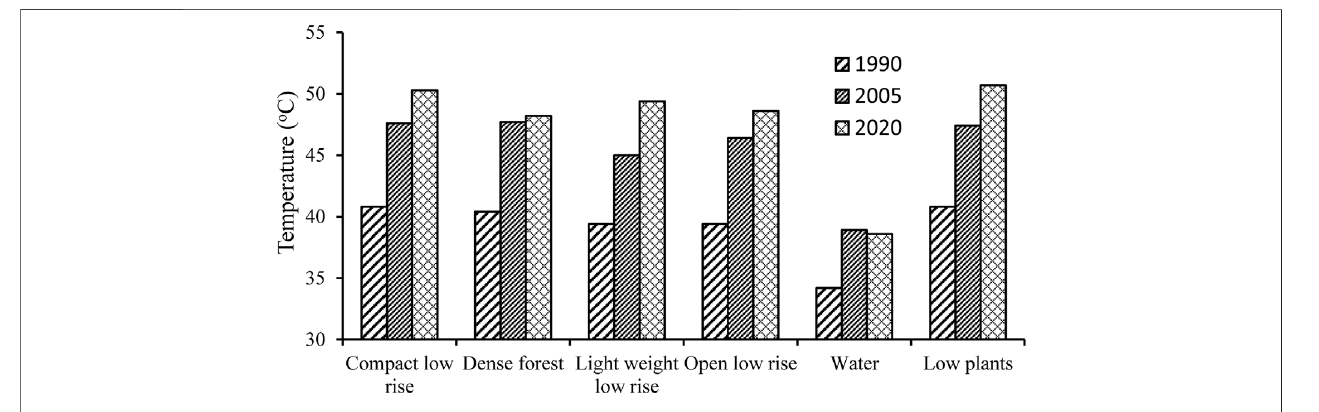
FIGURE 6 | Changes in mean LST across LCZs from 1990 to 2020 in Bulawayo.